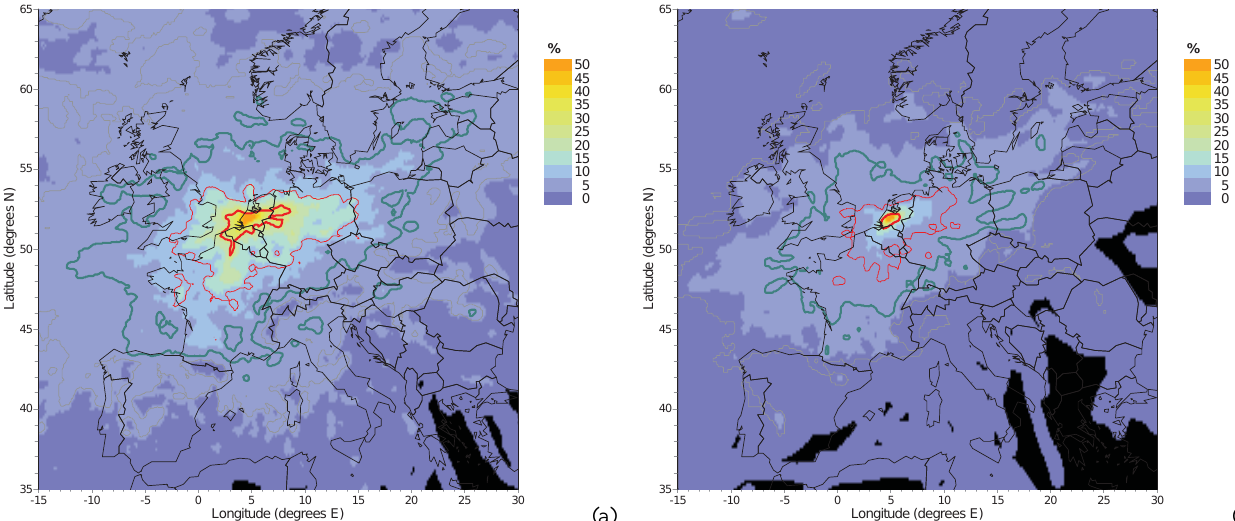
Fig. 2. (a) Total hourly concentration footprint (2008) for Cabauw 200m sampling level. First thick red contour contains the area with 25%, next thin red 50%, next thick green 75%, next thin gray 95% of total potential footprint. Colour scale is percentage of potential footprint per pixel relative to the maximum pixel value (see text); (b) total hourly concentration footprint (2008) for the Cabauw 20m sampling level, colour scale similar to (a) (see